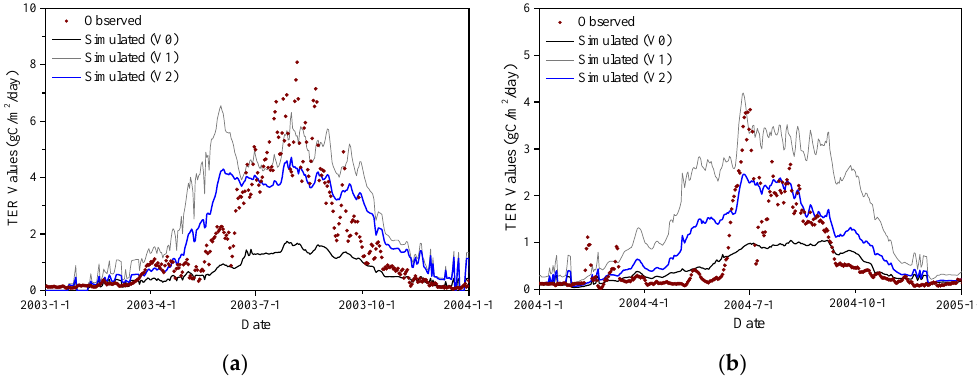
Figure 6. Comparisons between total ecosystem respiration (TER) derived from EC measurements and TER simulated by the version of V0, V1, and V2 for the calibration year. ( a ) Haibei Station (alpine meadow); ( b ) Damxung Station (alpine steppe).